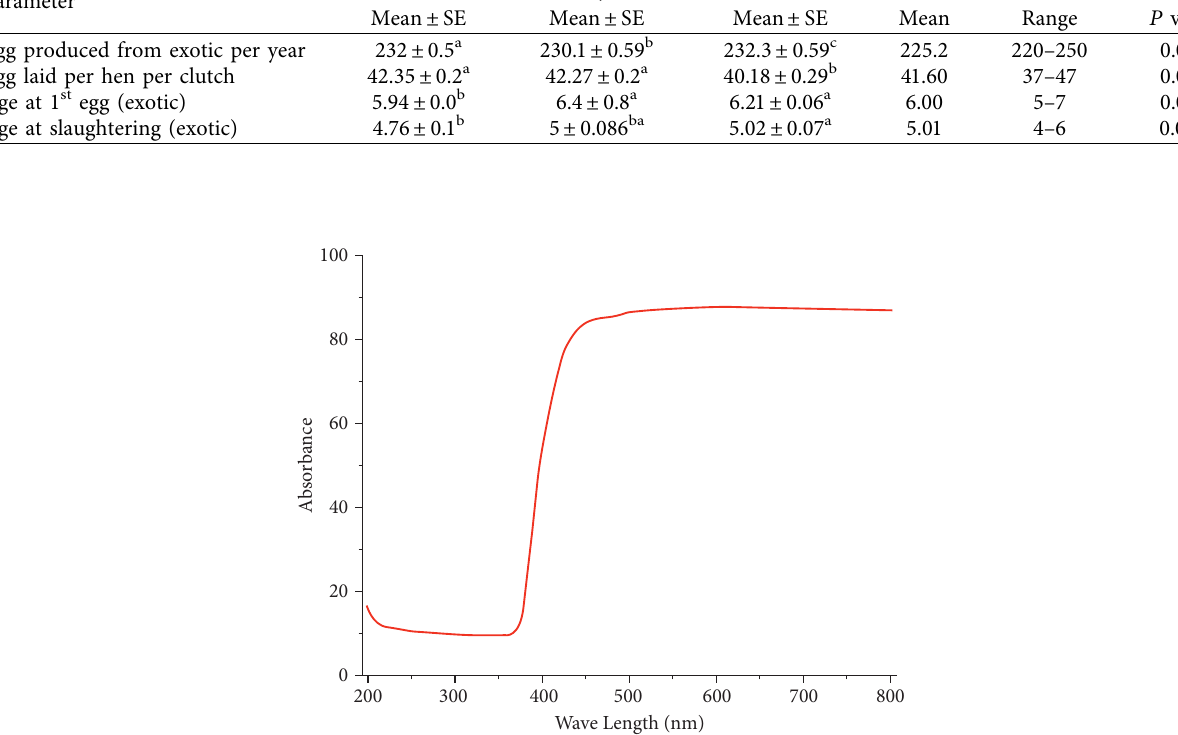
Table 2: Reproduction and manufacturing yields of the titanium dioxide nanoparticle coated improved poultry. Parameter